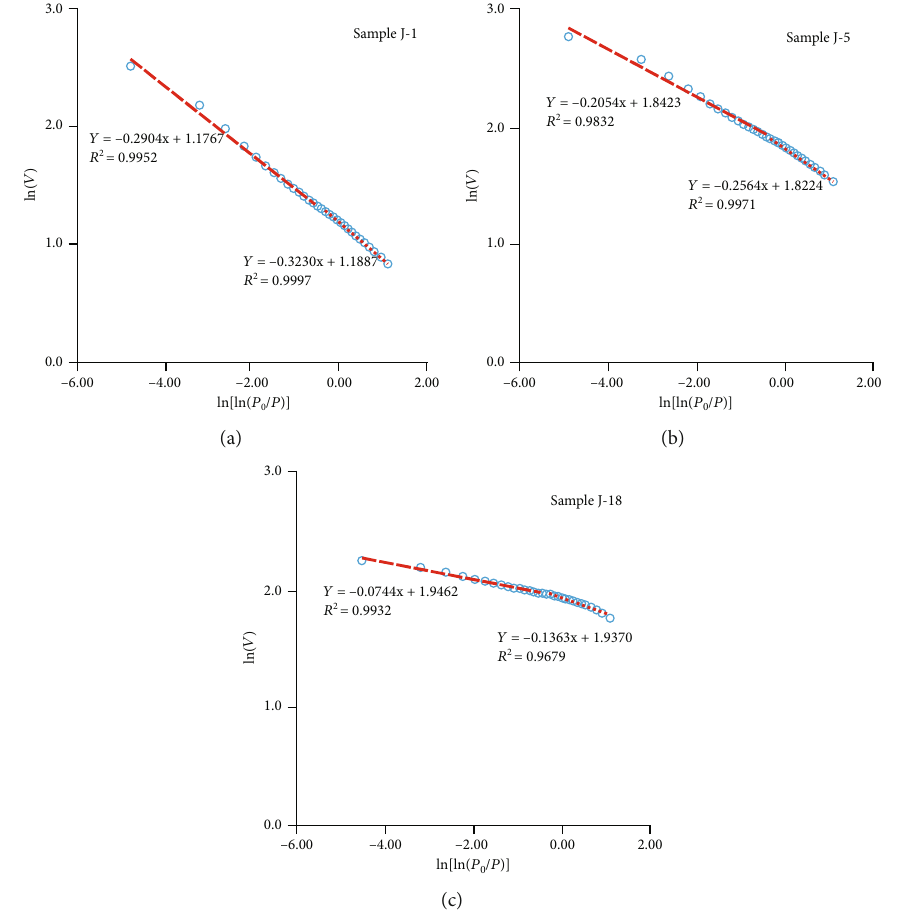
Figure 5: Fitting lines of pore fractal dimensions for Longtan shales.